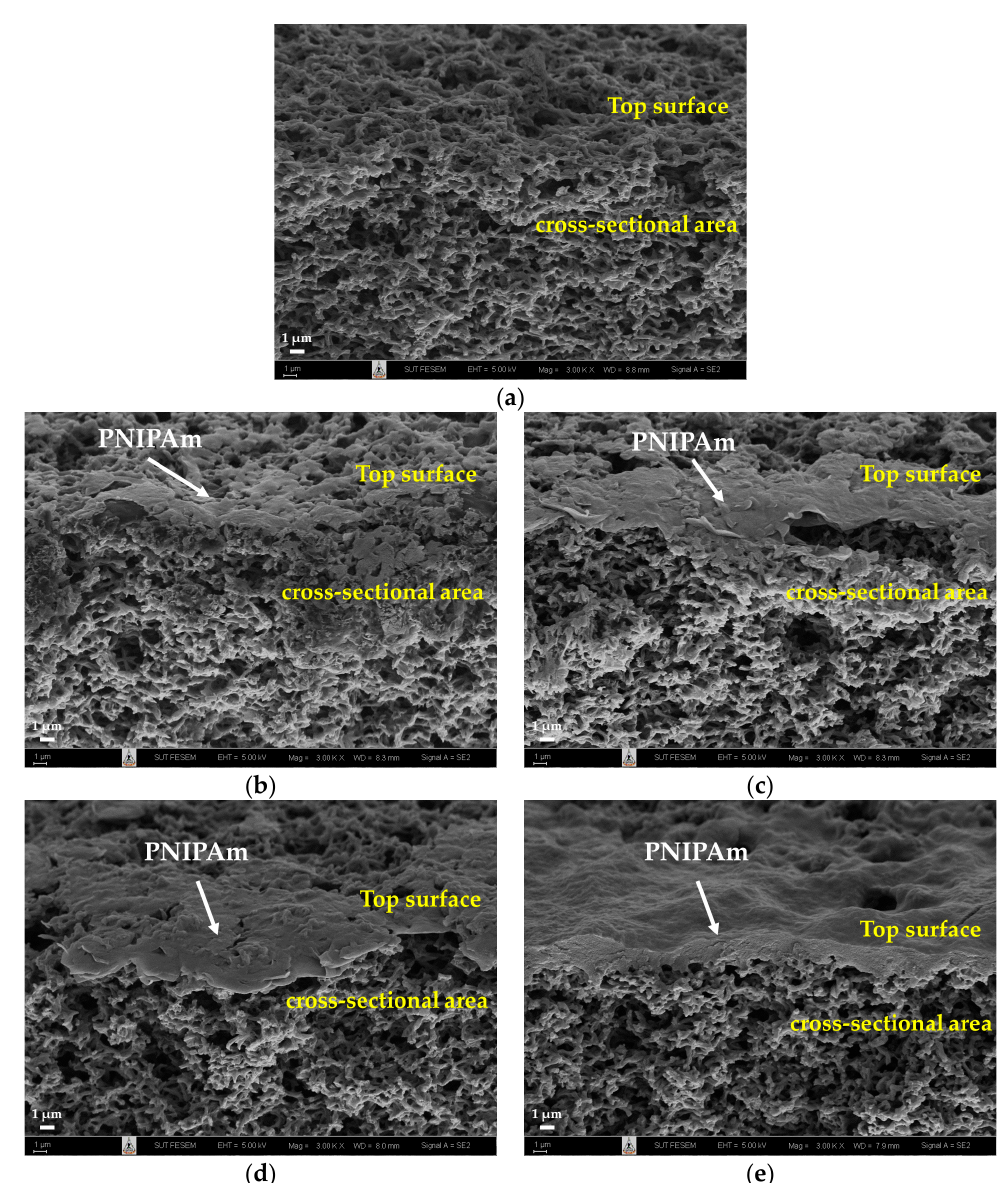
Figure 3. FE-SEM micrographs of cross - sections of ungrafted, linear, and crosslinked PNIPAm - grafted nylon membranes : ( a ) ungrafted nylon membrane; ( b ) linear PNIPAm - grafted nylon mem- nylon membranes: ( a ) ungrafted nylon membrane; ( b ) linear PNIPAm-grafted nylon membranes branes ( Y = 22 . 5% ) ; ( c ) crosslinked PNIPAm - grafted nylon membranes ( Y = 21 . 9% ) ; ( d ) linear ( Y = 22.5%); ( c ) crosslinked PNIPAm-grafted nylon membranes ( Y = 21.9%); ( d ) linear PNIPAm- PNIPAm - grafted nylon membranes ( Y = 43 . 2% ) ; ( e ) crosslinked PNIPAm - grafted nylon membranes grafted nylon membranes ( Y = 43.2%); ( e ) crosslinked PNIPAm-grafted nylon membranes ( Y = ( Y = 92 . 7% ).